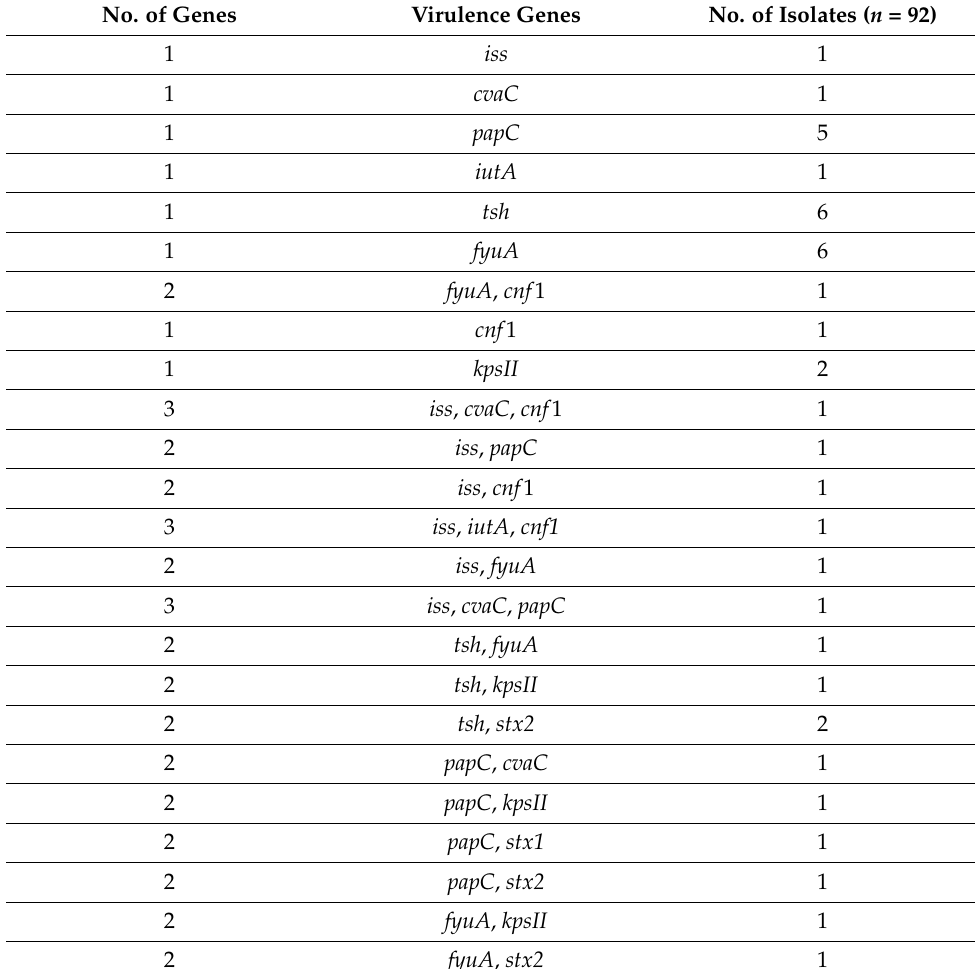
Table 4. Presence of virulence gene patterns in E. coli